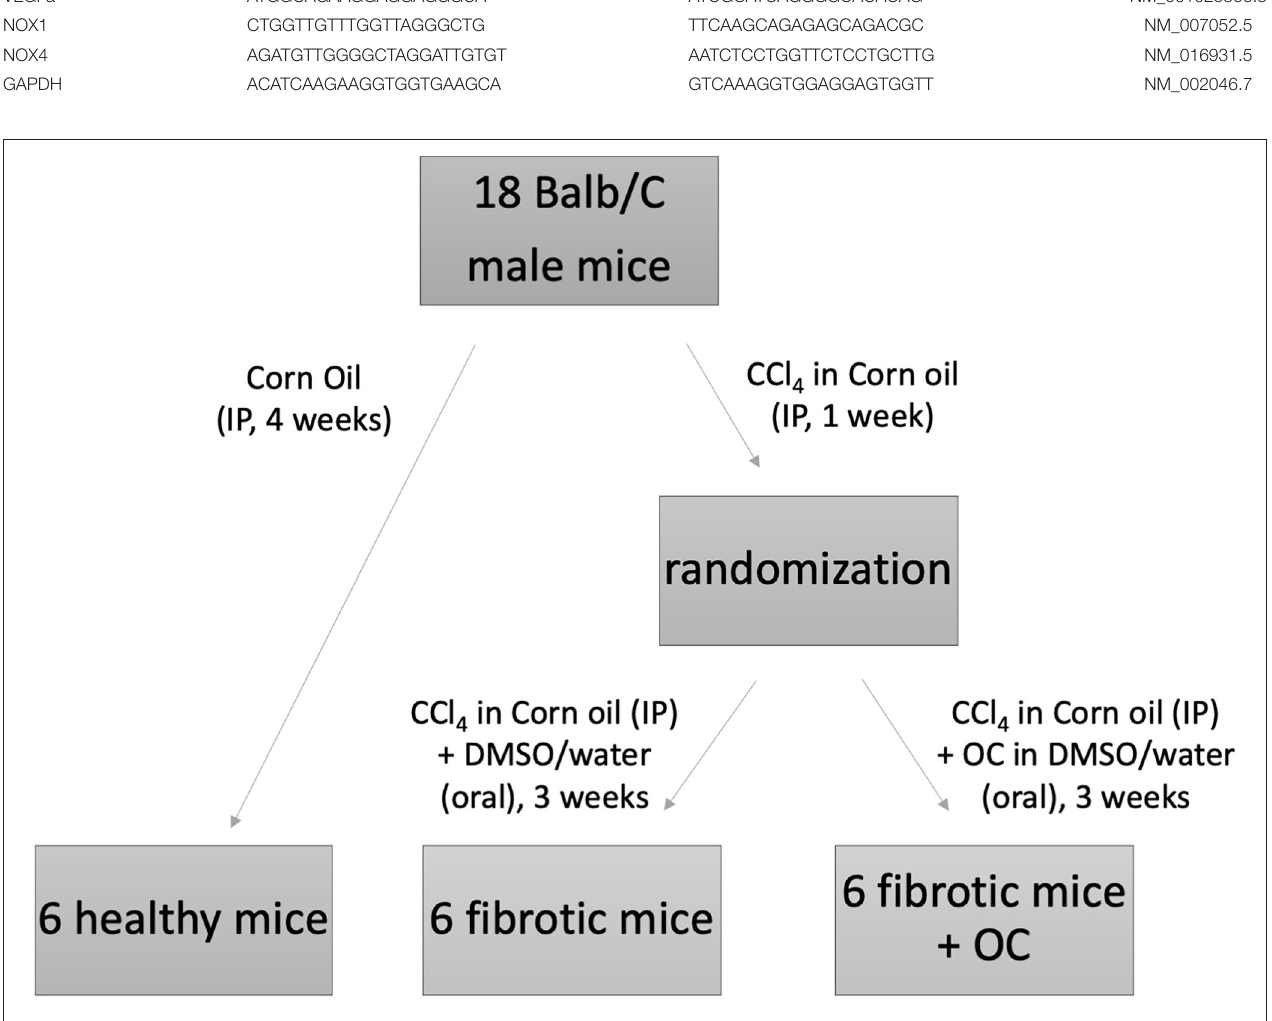
FIGURE 1 | Experimental design of the in vivo